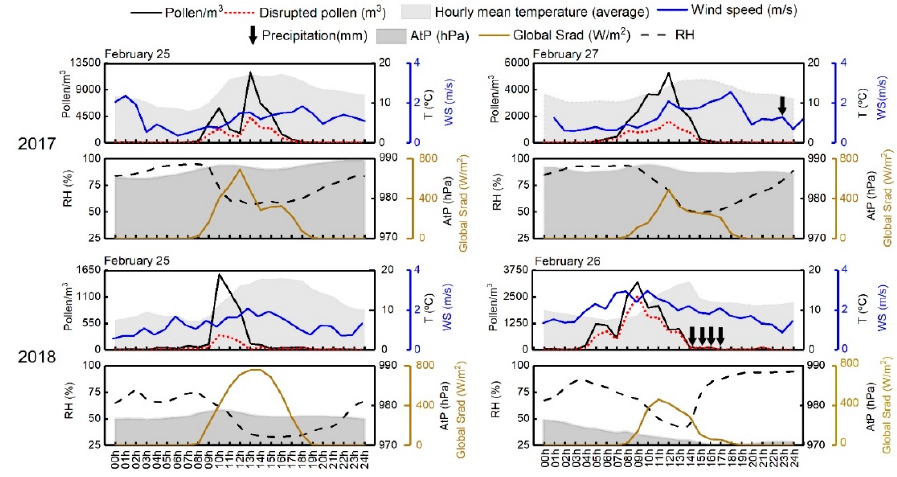
Figure 6. Hourly pollen concentration and meteorological parameters on 4 episodes of high pollen, 2 per year, with high and low pollen disruption